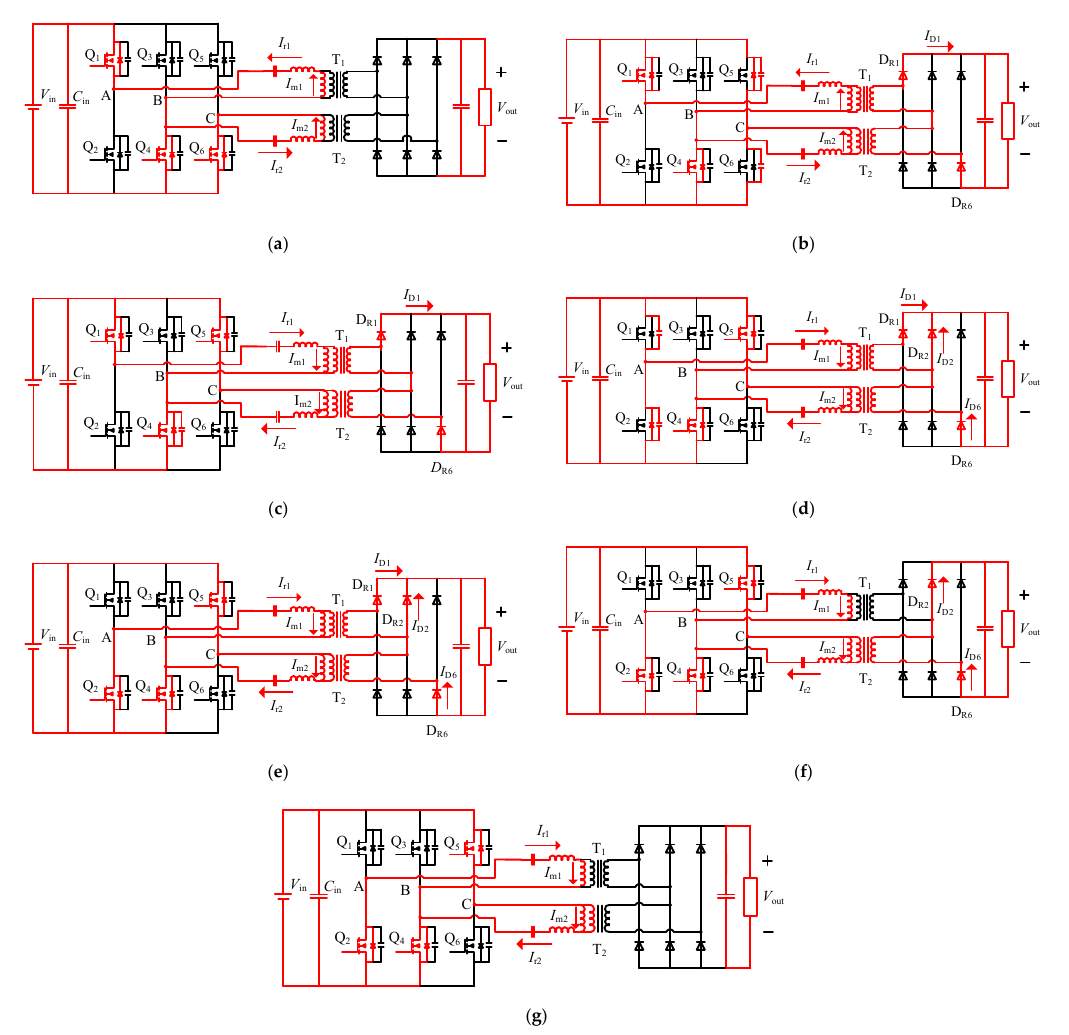
Figure 9. Main circuit diagram of each stage of the half-bridge phase-shift mode. The input terminal voltage V CB of tank circuit 2 increases from 0, and the